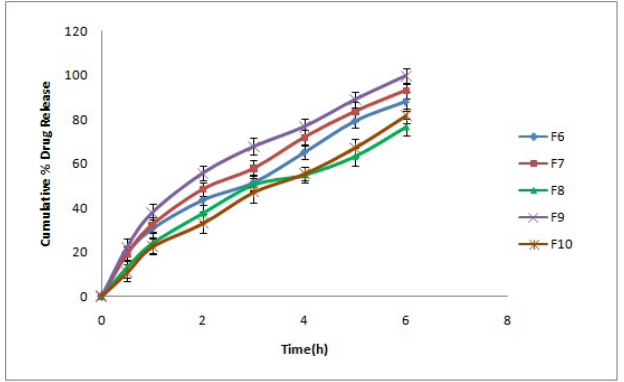
FIGURE 4 - In-vitro release profile of hydralazine hydrochloride muco-adhesive